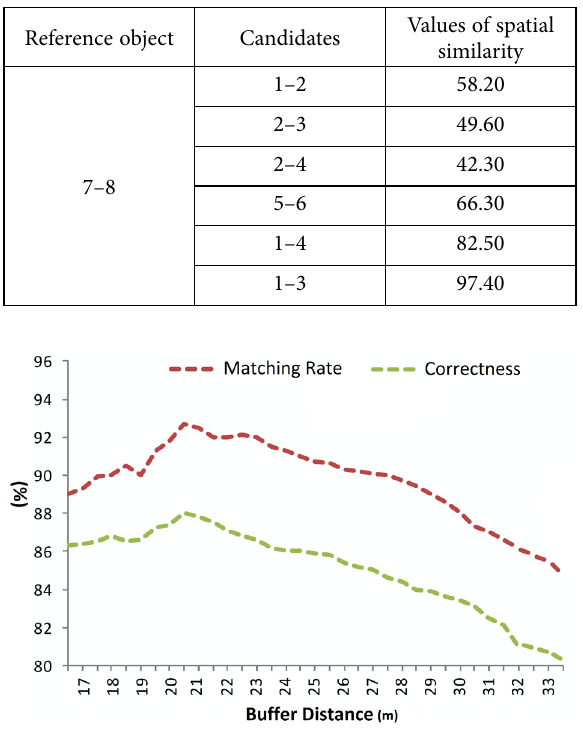
Fig. 19. Sensitivity analysis for the buffer distance